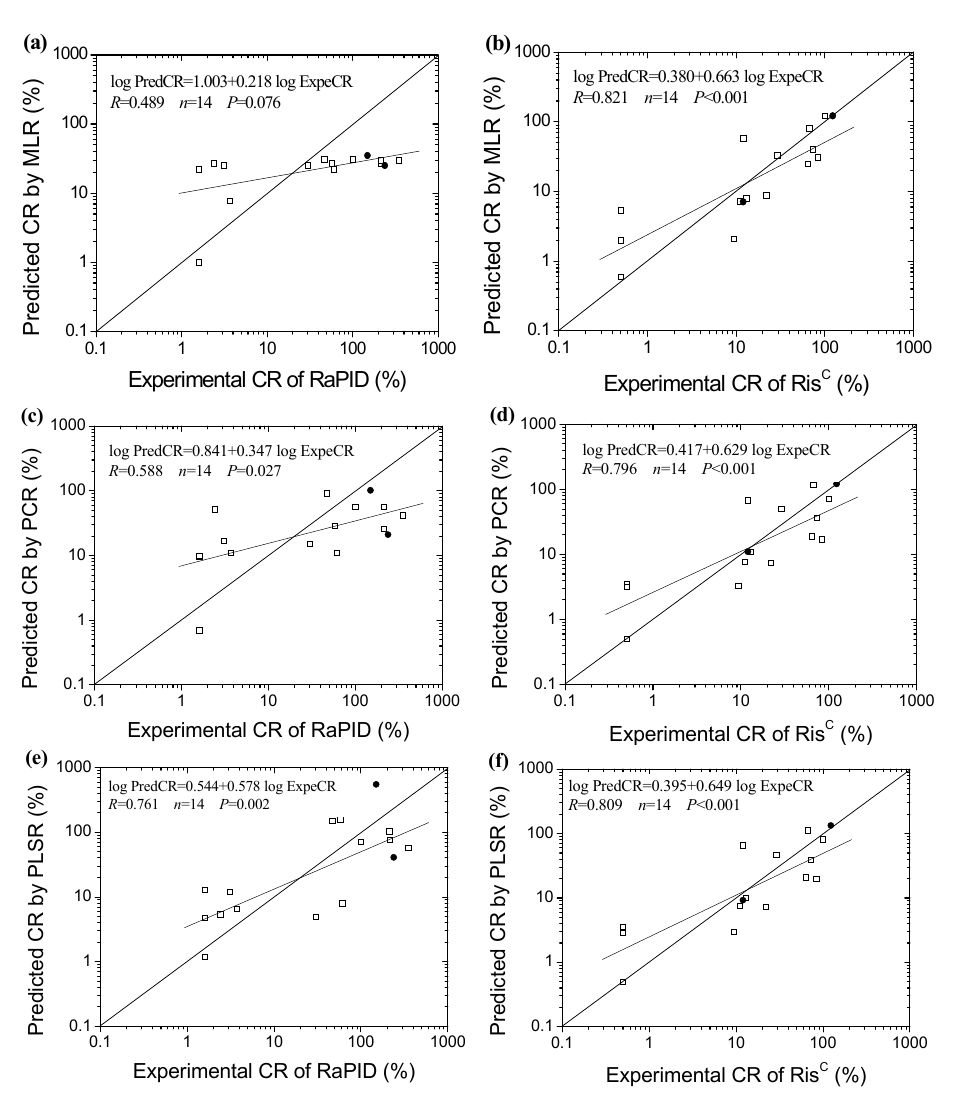
Figure 2. Plotting of predicted cross-reactivity (CR) versus experimental values of the PAHs